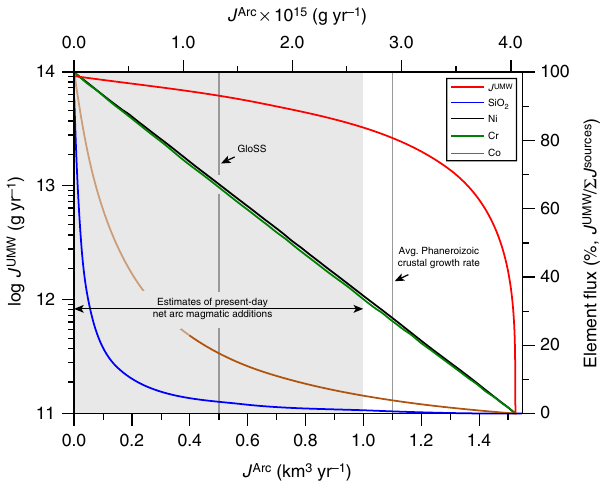
Fig. 10 Weathering and element fl uxes from ultrama fi c rock. The contribution of ultrama fi c rock weathering ( J UMW ) to balancing the Ni budget of the continental crust relative to the input from weathering of average andesite in volcanic arcs ( J Arc ) (red line, left-hand ordinate). The volcanic arc weathering fl ux is given as km 3 yr − 1 (i.e. Armstrong Units) to facilitate comparison with crustal growth rates. The secondary abscissa provides the volcanic arc weathering fl ux in g yr − 1 , calculated using the andesite density of 2.65 g cm − 3 . The right-hand ordinate shows the Ni, Cr, Co and SiO 2 release from ultrama fi c rock weathering as percentage relative to J UMW + J Arc . The grey shaded area represents the range of current estimates of crustal growth rates and the growth rate of 1.1 km 3 yr − 1 represents the average for the Phanerozoic 41, 51 . For volcanic arc weathering rates below 0.4 km 3 yr − 1 Co input from volcanic arc and ultrama fi c rock weathering is outweighed by Co removal from the